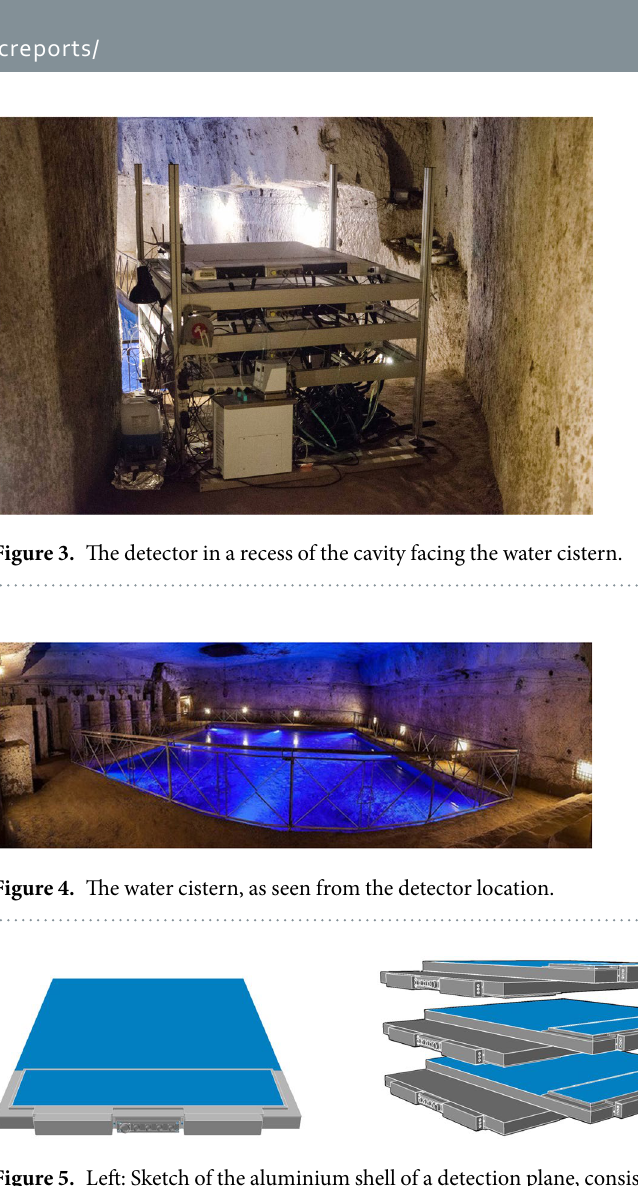
the fibres. The photosensors are based on the solid-state Silicon Photo-Multiplier (SiPM) technology, that allows